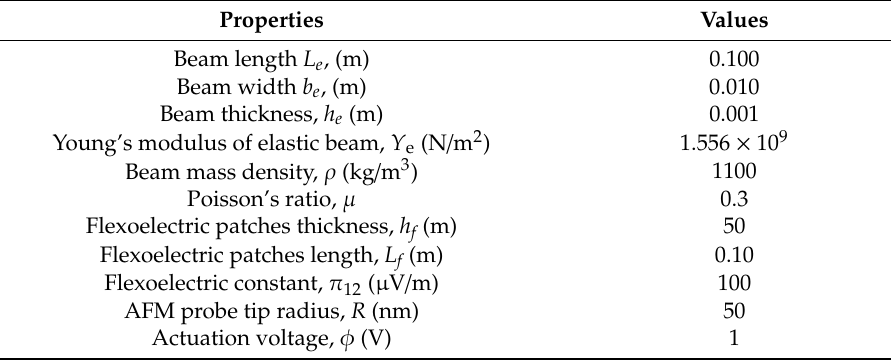
Table 1. Key parameters of the physical